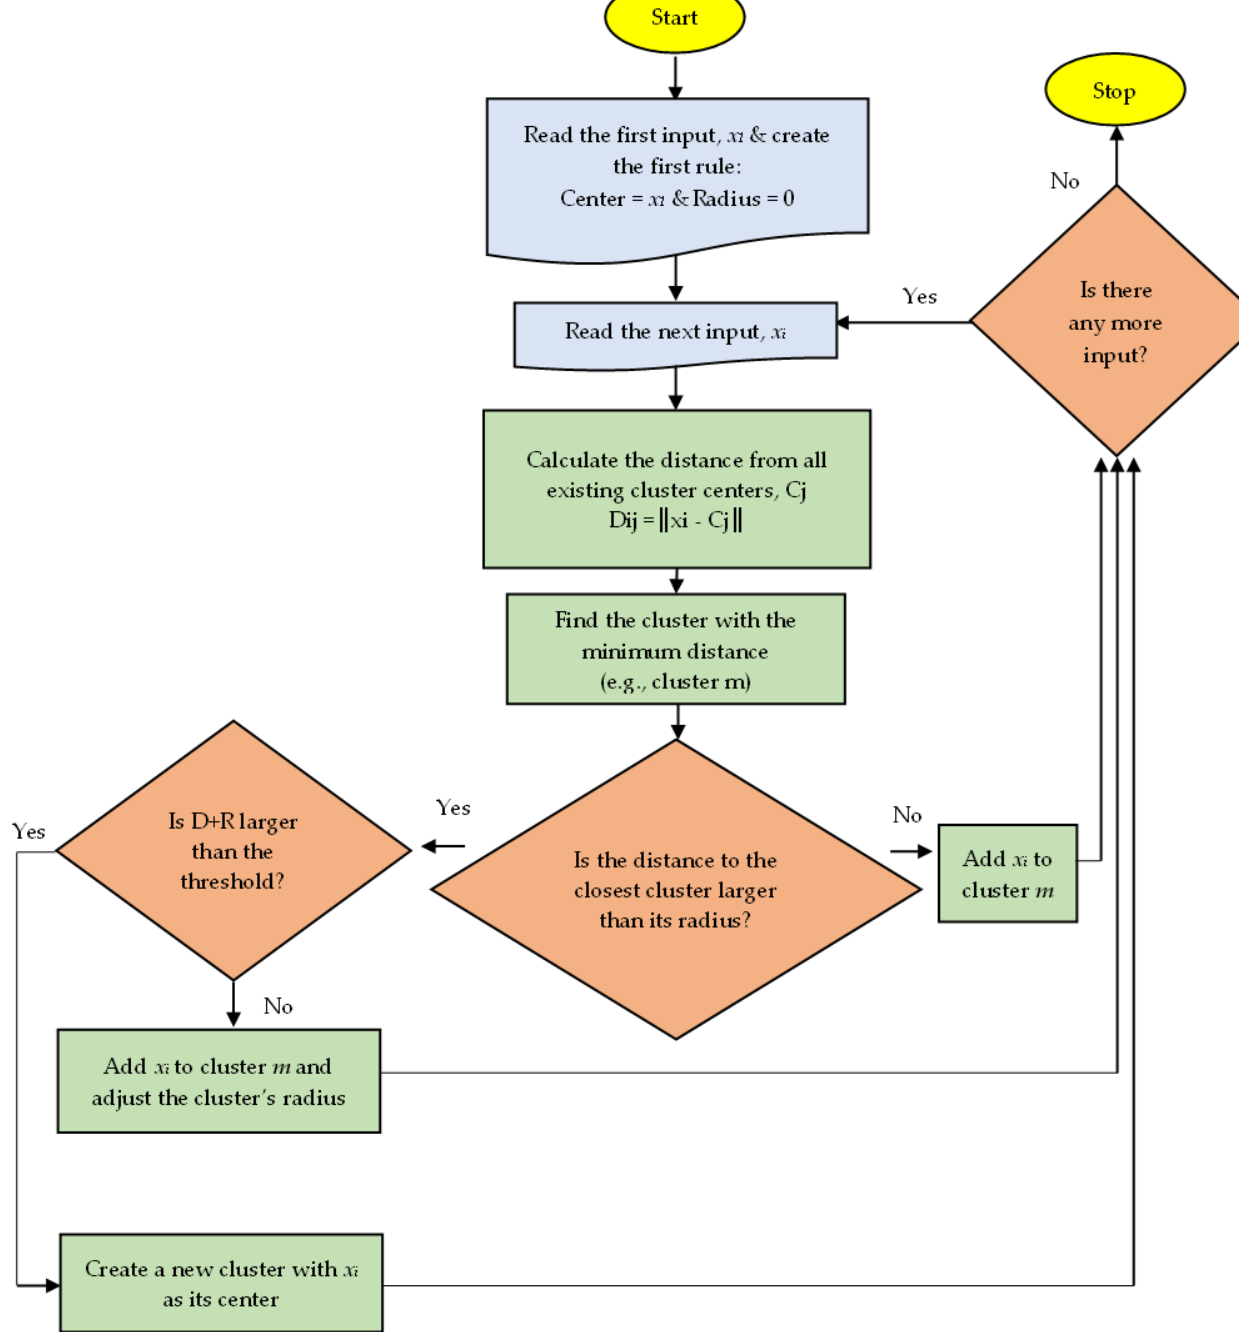
Figure 6. Flowchart of ECM algorithm used in DENFIS model.